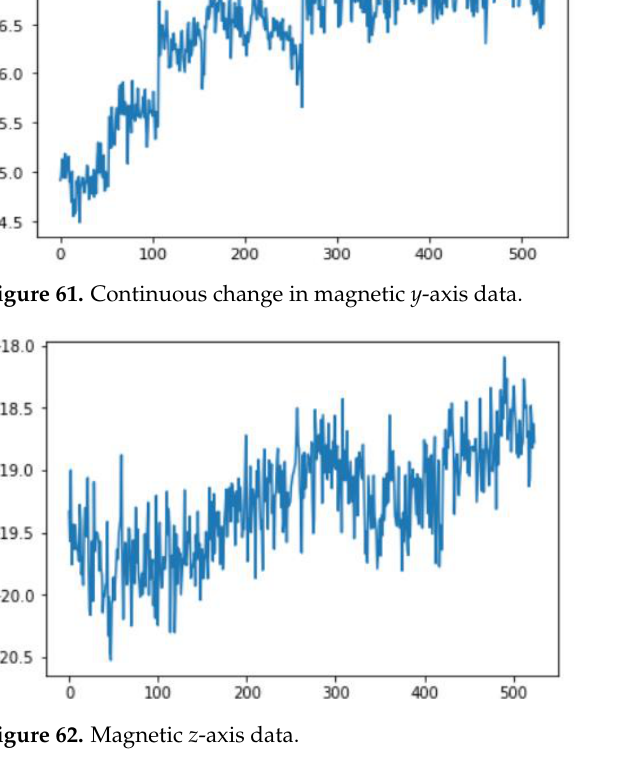
Figure 62. Magnetic z -axis data.